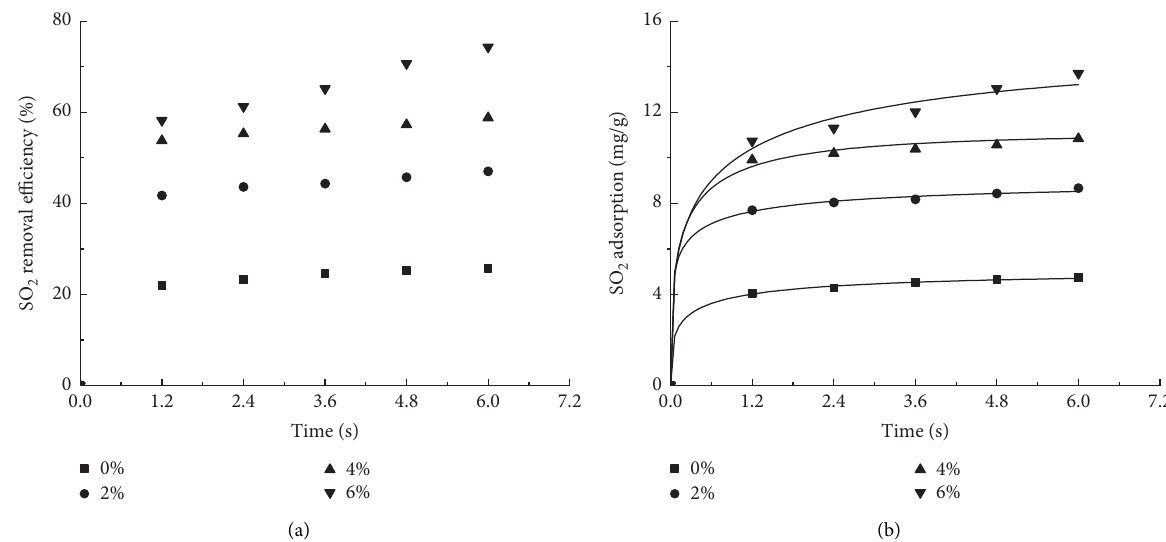
Figure 8: Influence of O 2 concentration on (a) SO 2 removal rate and (b) SO 2 adsorption. The temperature is 65 and SO 2 and H 2 O concentration is 0.085% and